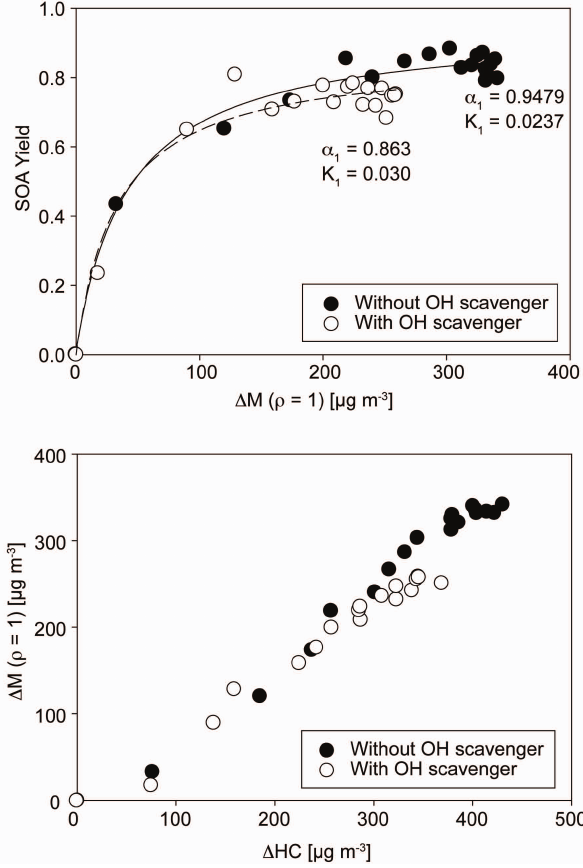
Fig. 1. SOA yield curves (top) and aerosol growth curves (bottom) for the campholenic aldehyde ozonolysis in the presence and ab- sence of CO as an OH radical